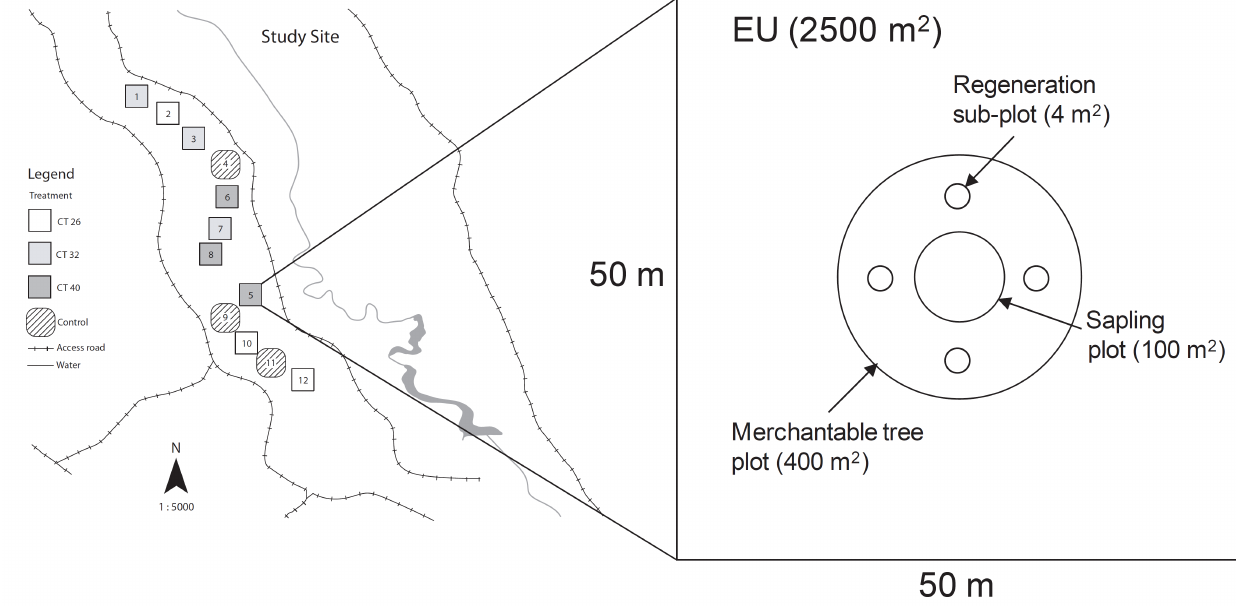
Figure 1. Layout of the study site, including details of the plot layout within experimental